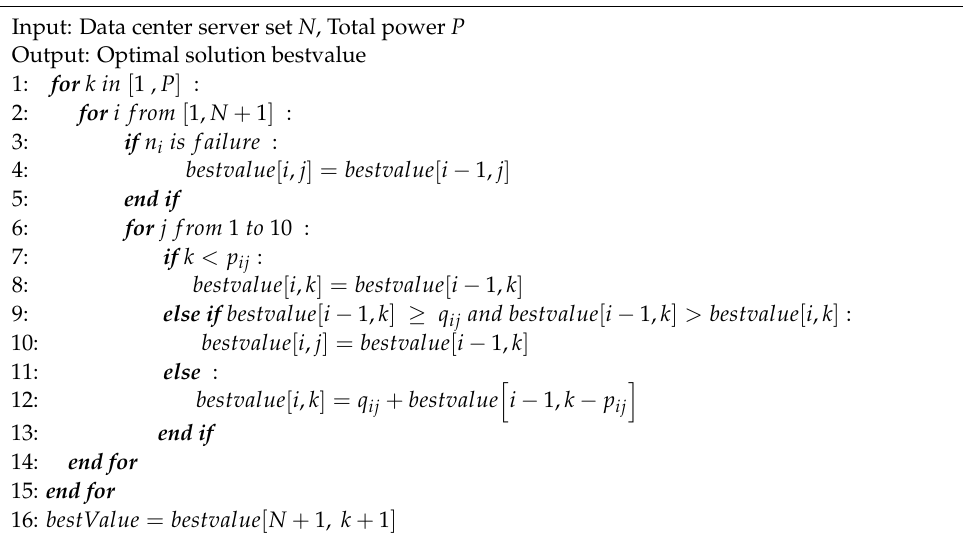
Algorithm 1: Maximizing throughput simulation